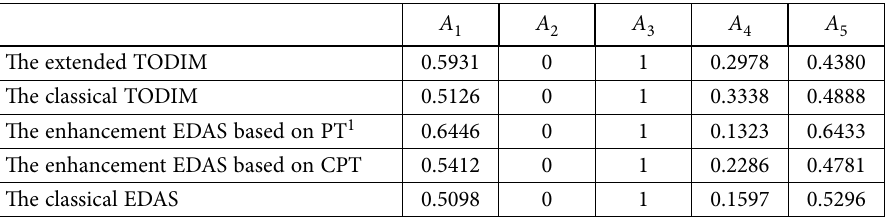
Table 18. The appraisal scores of different